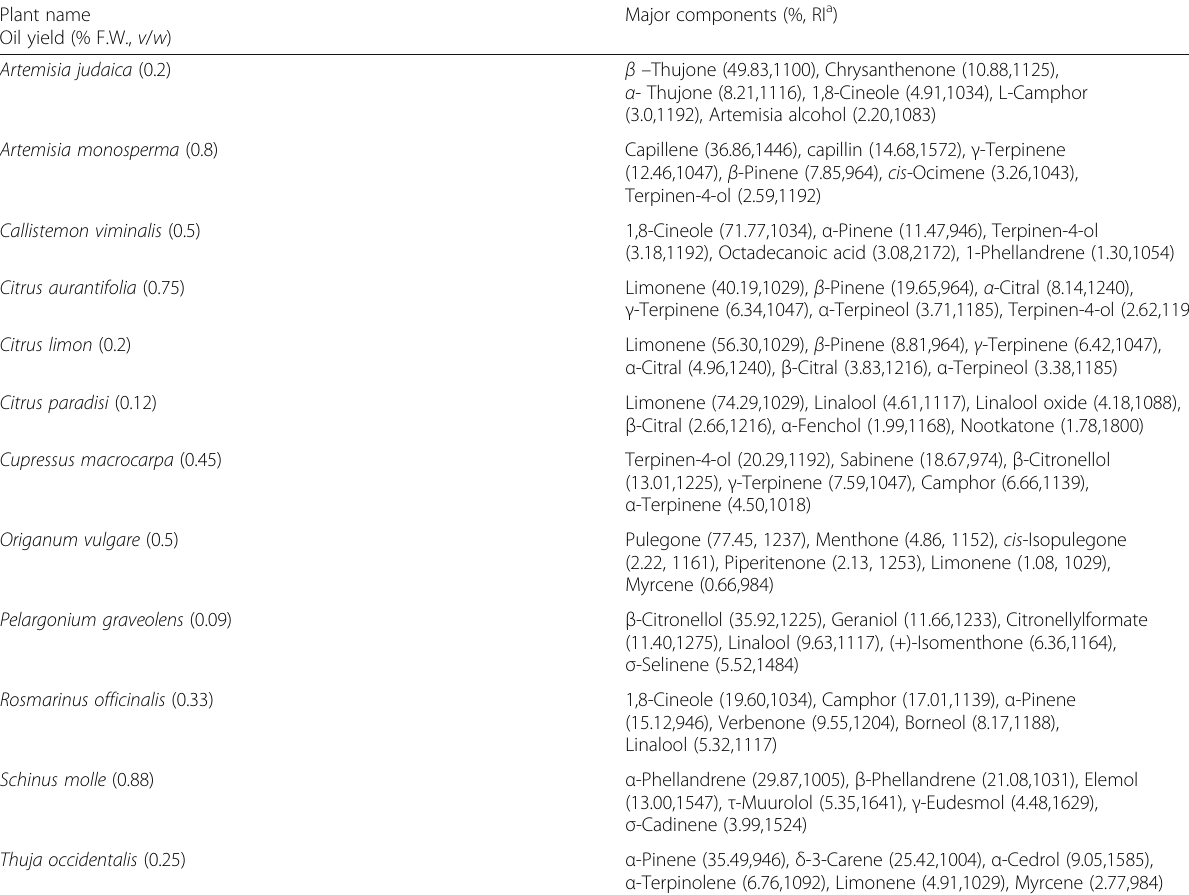
Table 1 Major constituents of essential oils extracted from twelve Egyptian plant species Plant name Oil yield (% F.W., v / w